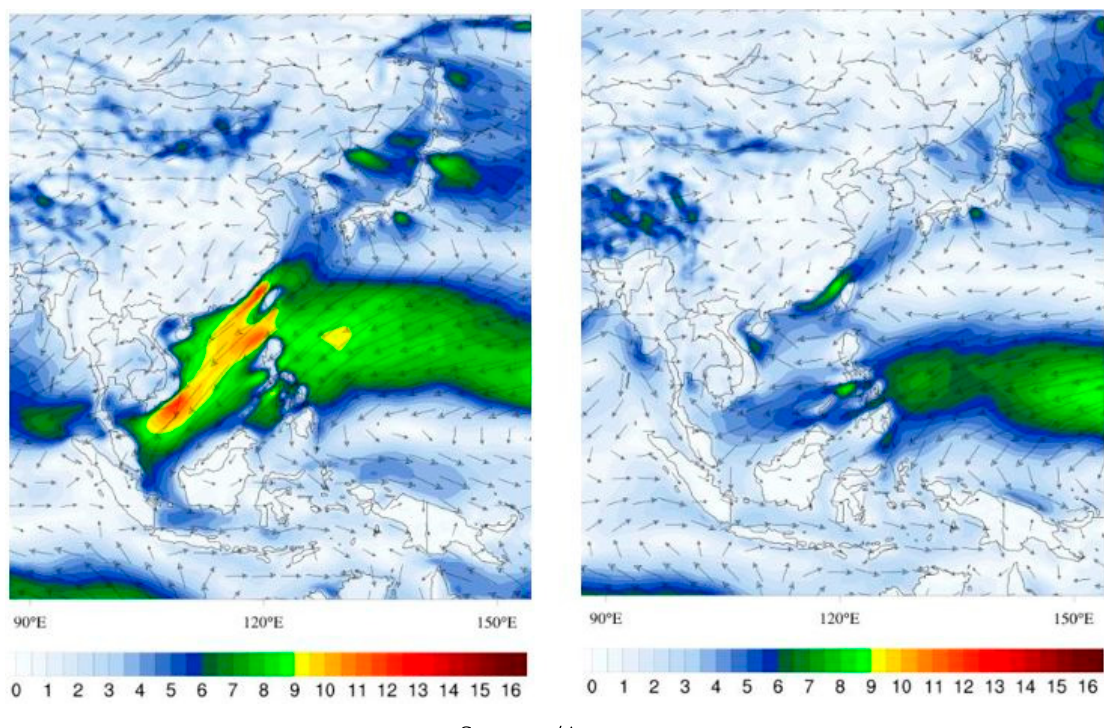
Figure 7. Map of winds in Asia/Pacific Ocean at 10 m, units in m/s. Referring to the Huanghe/Dalian System. Source: [50].